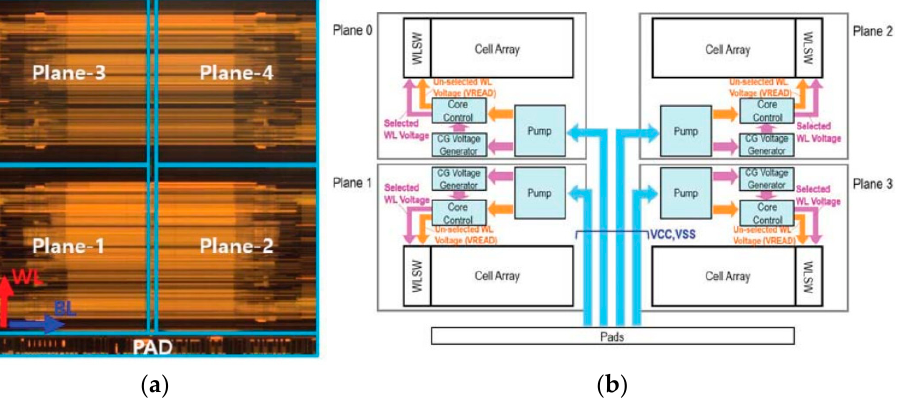
Figure 10. ( a ) Die photograph with a four-plane and 16 KB architecture. Reprinted/adapted with permission from Ref. [46], 2021, IEEE. ( b ) Four-plane asynchronous independent plane read floorplan. Reprinted/adapted with permission from Ref. [69], 2021, IEEE.